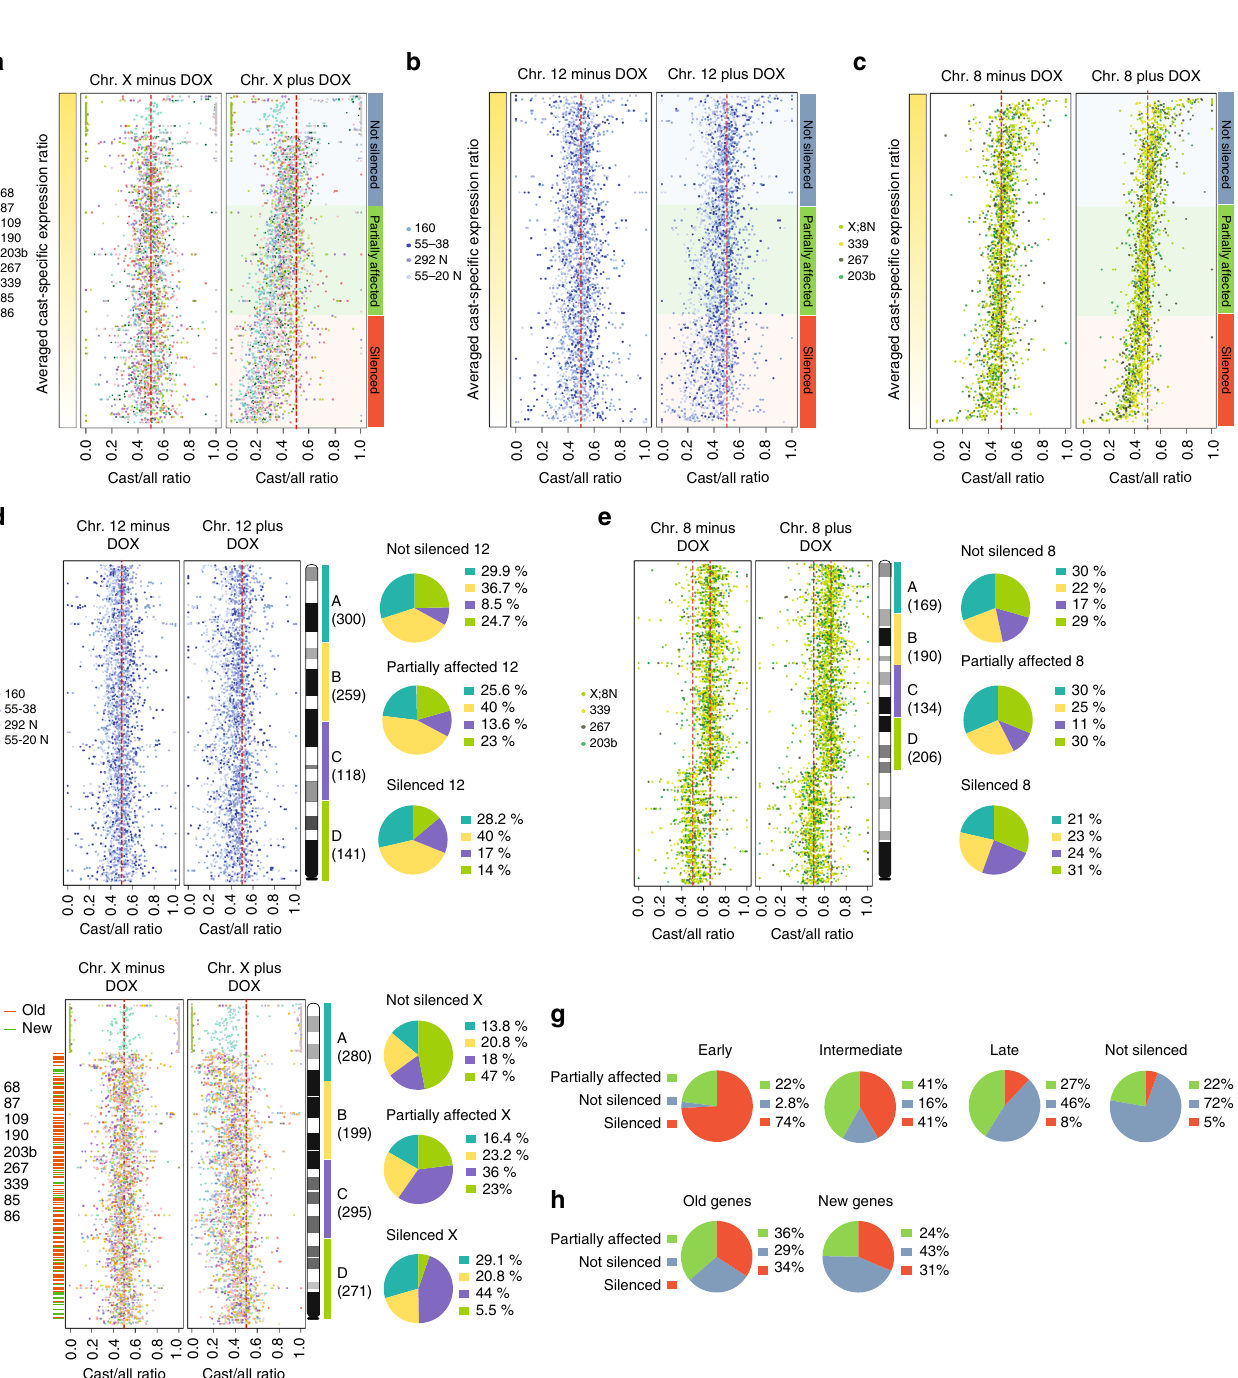
Fig. 5 Preferential silencing of speci fi c X-linked loci by ectopic Xist RNA. Gene silencing ranking plots for X-linked a , chromosome 12 b , and chromosome 8 c genes. Every dot represents the Cast/all expression ratio of a speci fi c gene. About 242 genes are shown in a , 351 in b , and 336 in c . Genes are ranked based on the averaged Cast/all ratio among all clones in each group of clones (Tg-E, Tg-X, Tg-X;8, and Tg-12). Ranked genes are divided in three categories (I) ef fi ciently silenced, (II) partially affected, and (III) not silenced genes. To simplify data visualization, the Cast/all ratios were transformed as follows: (1) For Tg-X;8 clones, carrying Xist transgenes on the 129/sv X chromosome, we used the reciprocal of the Cast/all ratio. Thus, all clones carrying an X-linked Xist transgene behave as if the transgene was integrated on the Cast/Ei X chromosome. (2) For Tg-12 and Tg-X;8 clones, we converted the data from trisomic to disomic by calculating a new Cast/all ratio = (NCast/2)/(NCast/2 + N129). d – f Genes are ordered by genomic position. Pie graphs show the amount of overlap between the gene categories denoted in a – c and chromosomal regions A, B, C, and D on chromosomes X, 12, and 8. Gene density along chromosomal regions A, B, C, and D is indicated in brackets. In f , red and green lines represent evolutionary old and new X-linked genes, respectively. g , h Pie graphs showing the proportion of ef fi ciently silenced, partially affected, and not silenced X-linked genes overlapping with gene clusters that show different inactivation dynamics upon cell differentiation ( g ) and evolutionary old and new X-linked genes ( h